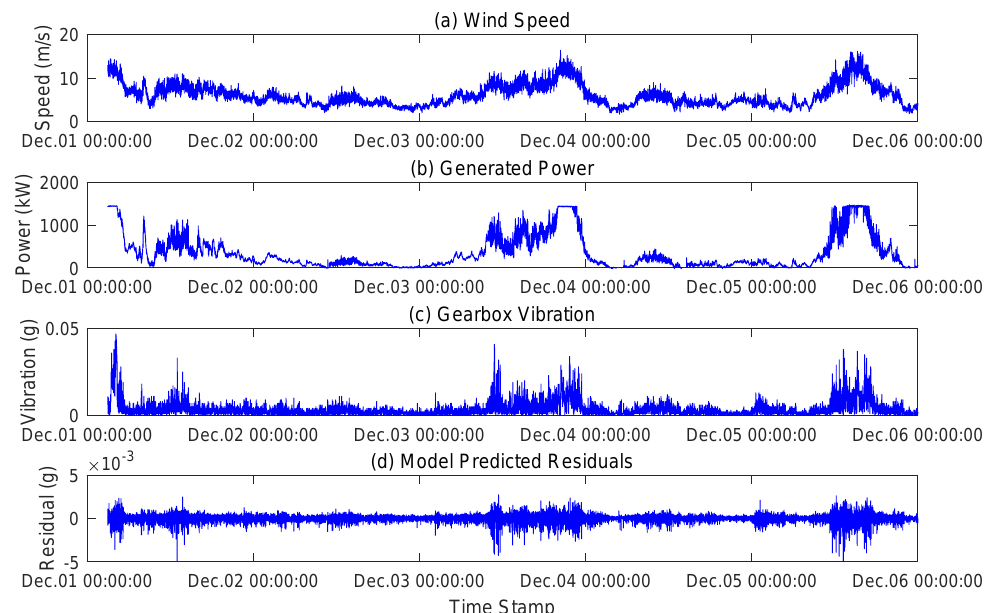
Figure 5. An example of gearbox vibration and its residuals along with the corresponding operational parameters, wind speed and generated power.